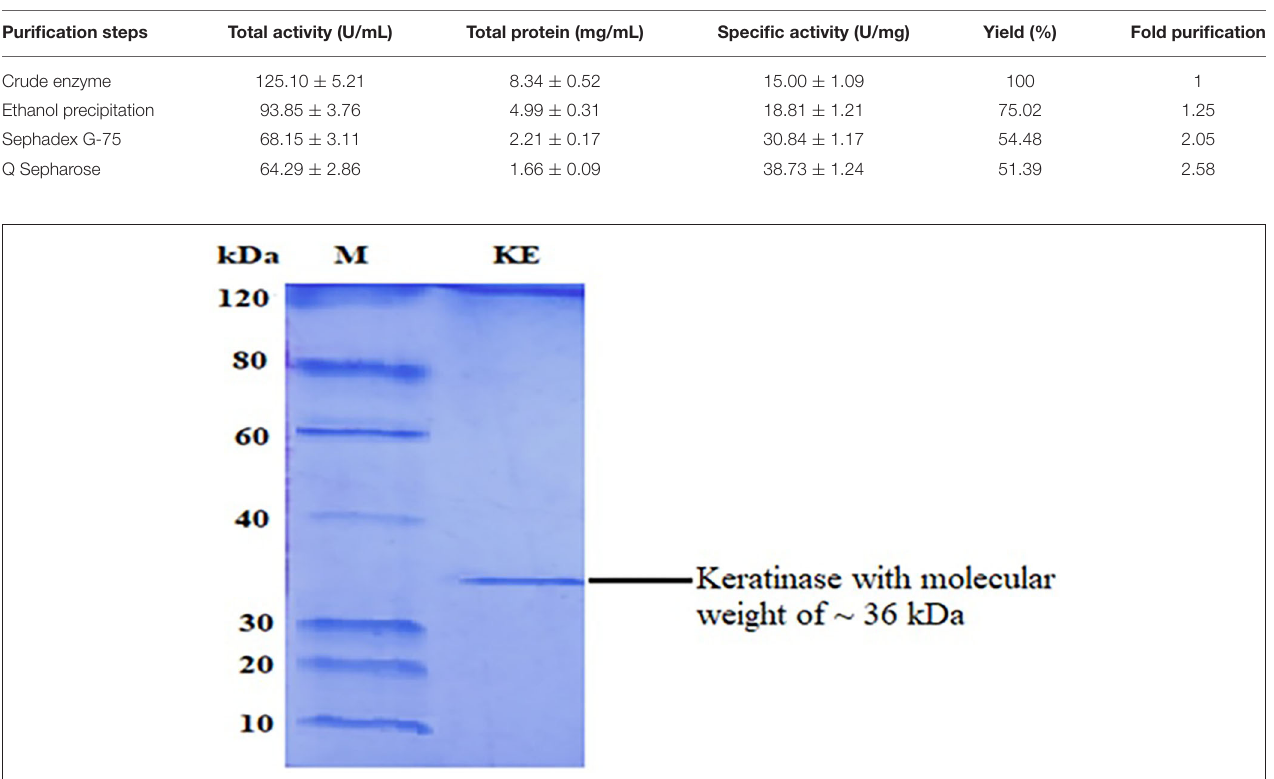
TABLE 1 | Purification parameters of keratinase from Bacillus pacificus RSA27.